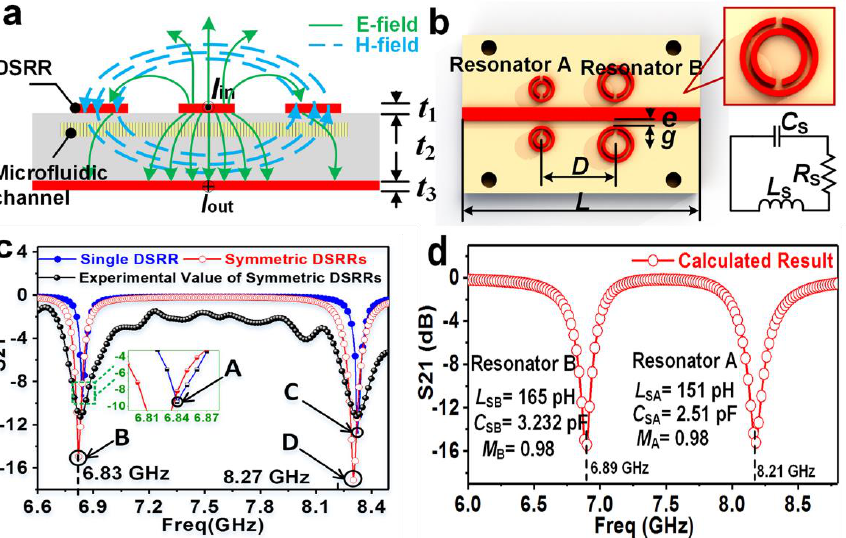
Figure 13. Electrical analysis of the MIM sensor. ( a ) Cross-section of a microstrip transmission line with a pair of DSRR and its electric field (E-field) and magnetic field (H-field) distribution (Thickness: t 1 = 3.5 μm, t 2 = 0.609 mm, t 3 = 3.5 μm). ( b ) The equivalent circuit of DSRR. ( c ) The calculated results from the equivalent circuit of the microfluidic sensor by ADS software. ( d ) The simulated and experimental S21 spectrum of single or symmetric DSRRs. Points A and B represent resonances excited by single and dual resonator B, respectively. Points C and D represent resonances excited by single and dual resonator A, respectively [133] Copyright © 2018, Nature, Scientific